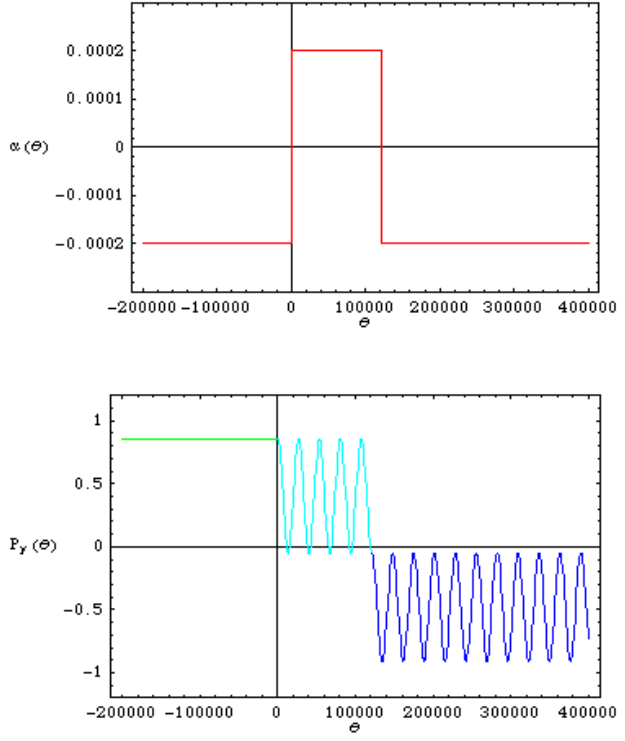
j has been 0 j (cid:1) A (cid:1) 2 (cid:11) 10 (cid:3) 4 . 0